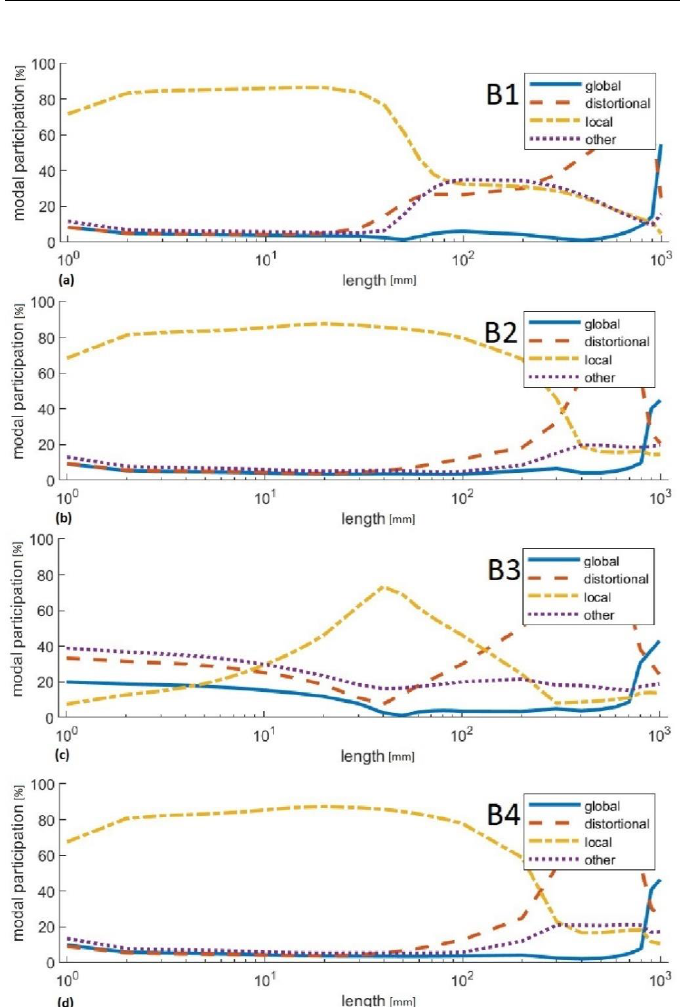
Figure 13. Percentage contribution of individual buckling forms to the loss of stability of the tested columns: ( a ) Results for column B1. ( b ) Results for column B2. ( c ) Results for column B3. ( d ) Results for column B4.